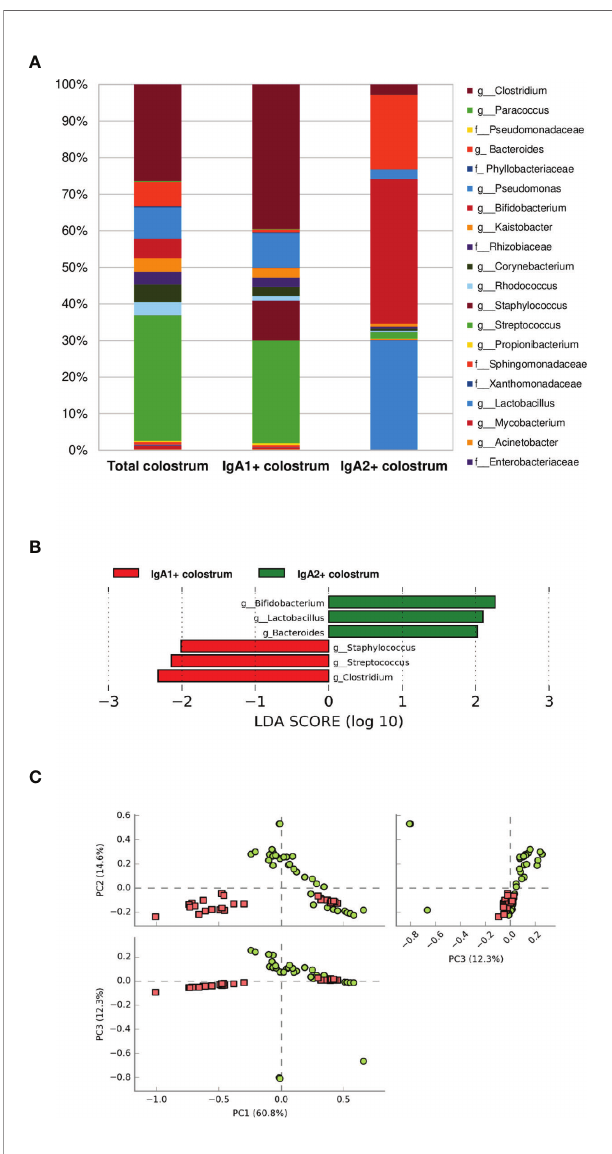
FIGURE 2 | Some bacteria have divergent recognition between IgA subclasses in the human colostrum. (A) Relative abundance of predominant bacterial taxa in colostrum samples. Abundance of each families/genera in IgA fractions (Total bacteria in colostrum = Total colostrum, bacteria coated with IgA1= IgA1+ colostrum, and bacteria coated with IgA2 = IgA2+ colostrum). IgA1+ fraction is plotted as red dots and IgA2+ fraction as green dots. Previous graphs represent data from thirty-six “ Total bacteria, ” thirty “ IgA1+ colostrum, ” and thirty-three “ IgA2+ colostrum ” samples. Both groups signi fi cantly differed according to the ANOSIM similarity test (R 2 = 0.289, p = 0.001) and Adonis statistical test (R 2 = 0.949, p = 0.001). (B) LEfSe analysis of the most representative bacterial genera in colostrum by IgA1 and IgA2. Linear discriminant analysis (LDA) effect size (LEfSe) compares differential abundant bacterial taxa between IgA fractions. Horizontal bars represent each taxon ’ s effect size: green indicates taxa enriched in the IgA2+ fraction group, and red indicates taxa enriched IgA1+ fraction. LDA score cutoff of 2.0 was used to discriminate bacterial taxon. (C) Beta diversity analysis. Two-dimensional scatterplots were generated using PCoA based on the unweighted UniFrac distance metric. PC3 vs PC2, PC1 vs PC2, and PC1 vs